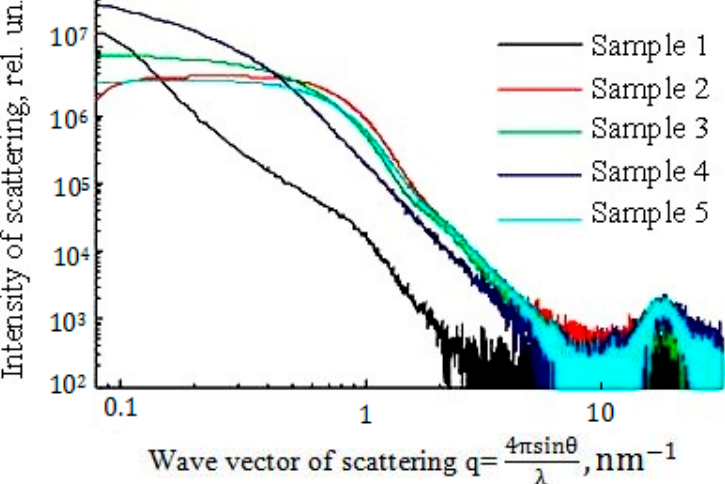
Figure 14. The results of measurements by the method of small-angle X-ray scattering.